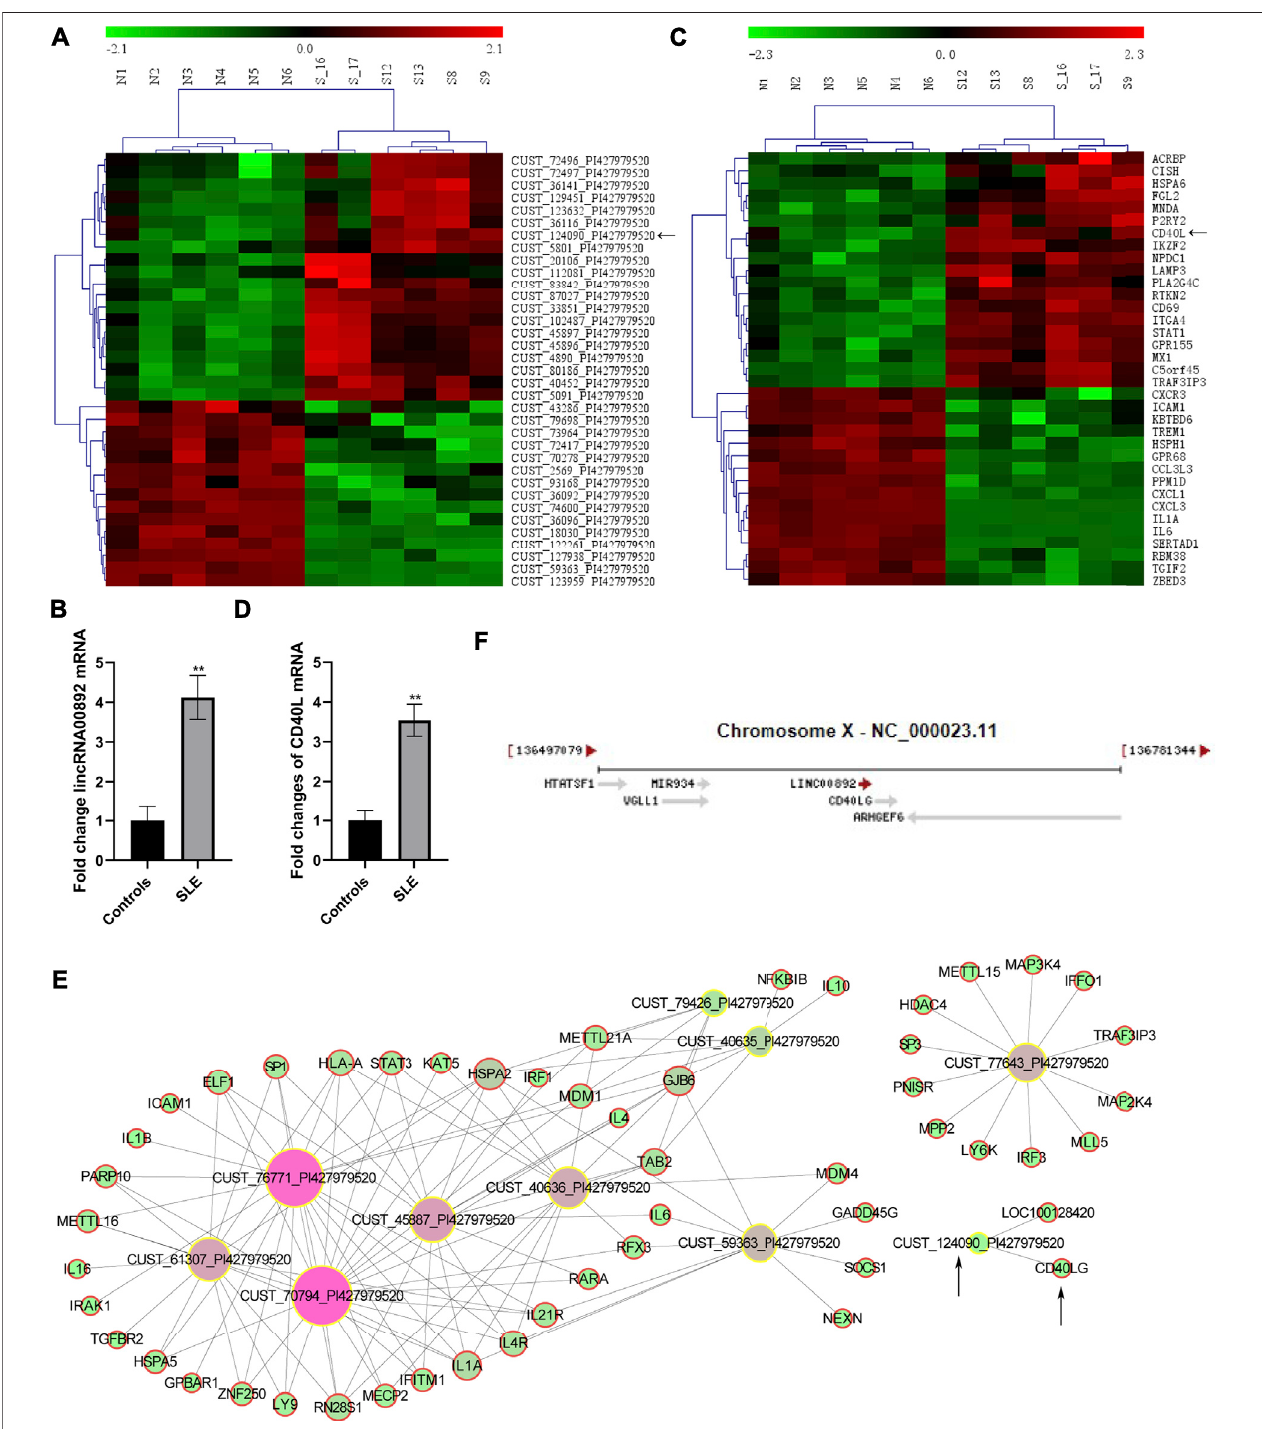
FIGURE 1 | LncRNA CUST124090 (lincRNA00892) and CD40L were upregulated in CD4 + T cells of SLE patients. (A) Hierarchically clustered heatmaps of some lncRNAs that were upregulated in CD4 + T cells in SLE patients ( n (cid:1) 6) as compared to healthy controls ( n (cid:1) 6). (B) qRT-PCR was used to verify the expression of lincRNA00892 in CD4 + T cells of SLE patients ( n (cid:1) 36) and healthy controls ( n (cid:1) 28). (C) Hierarchically clustered heatmaps of some mRNAs that were upregulated in CD4 + TcellsofSLEpatients( n (cid:1) 6)ascomparedtohealthycontrols( n (cid:1) 6). (D) qRT-PCRwasperformedtodetecttheexpressionofCD40LinCD4 + TcellsofSLE patients ( n (cid:1) 36) and healthy controls ( n (cid:1) 28). (E) Coexpression network analysis of some lncRNAs and predicted targeted mRNAs. (F) The location of both lincRNA00892andCD40LinchromosomeX.** p < 0.01,* p < 0.05.Theresultsareexpressedasmean ± standarddeviation.Student ’ st-testwasusedforcomparisonof two